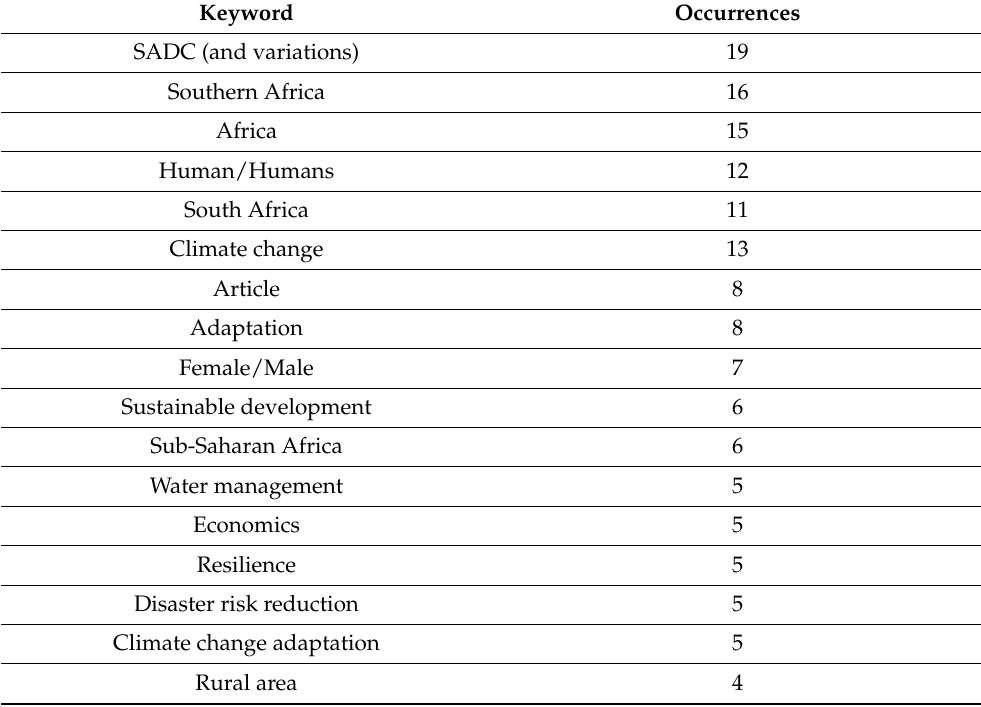
Table 2. Keywords and occurrences in SADC resilience